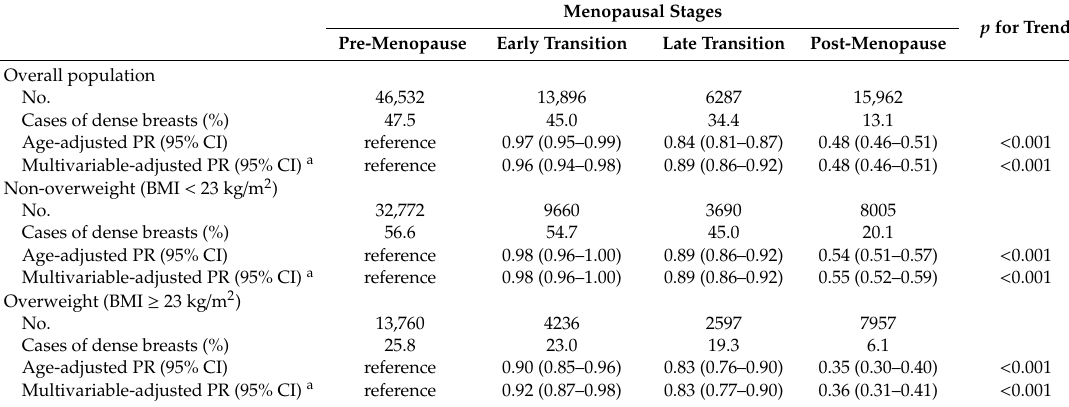
Table 2. Dense-breast prevalence according to menopausal stage among overall, overweight, and non-overweight